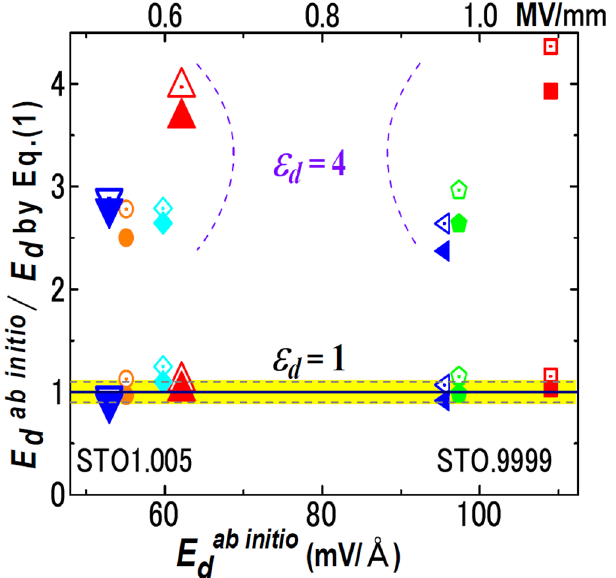
Figure 3. FE/vacuum. Comparison of E d ab initio with Eq. (1) with ε d = 1, 4 for STO1.005/vacuum and STO0.9999/ vacuum. The yellow band shows the range of 1 ± 0.1. The filled and open symbols represent data in which l f in Eq. (2) is estimated with λ smear = 0.8 Å and λ smear = c /2, respectively. The shape of symbol indicates a slab structure: For STO1.005, orange circles, red triangles, light blue diamonds, and blue inverted triangles correspond to 7-unit-cell-STO with l V = 30 Å, 7-unit-cell-STO with l V = 200 Å, 10-unit-cell-STO with l V = 30 Å, and 10-unit-cell-STO with l V = 100 Å, respectively. For STO0.9999, red squares, green pentagons, and blue 90°-rotated triangles correspond to 5-unit-cell-STO with l V = 300 Å, 6-unit-cell-STO with l V = 30 Å, and 7-unit- cell-STO with l V = 30 Å, respectively.